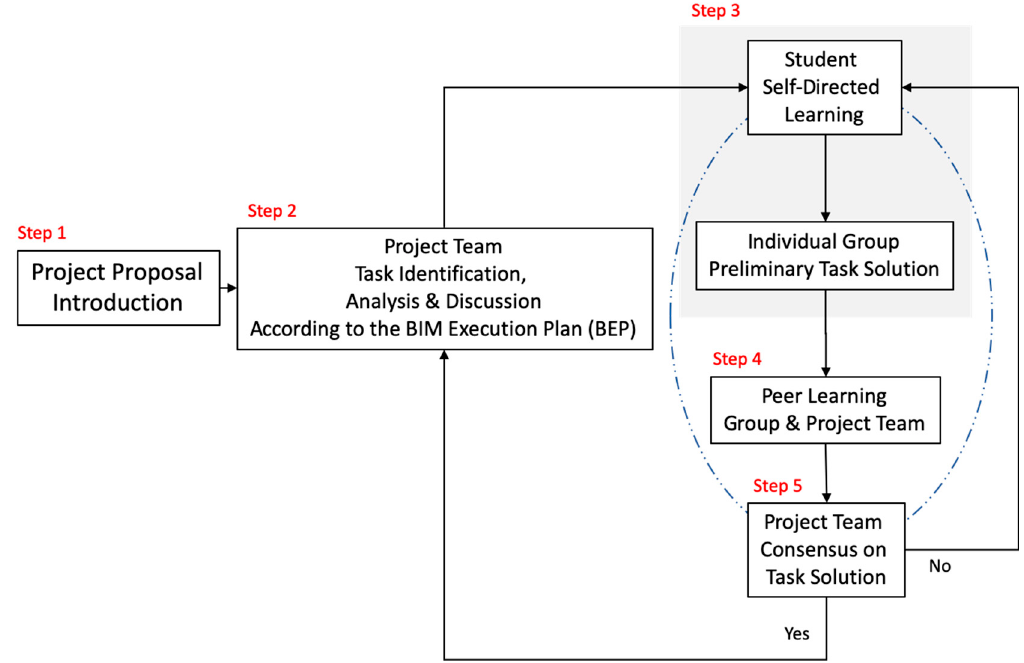
Figure 1. Building information modeling ( BIM) implementation in final project degree subject: Overview of the active collaborative learning methodology applied.